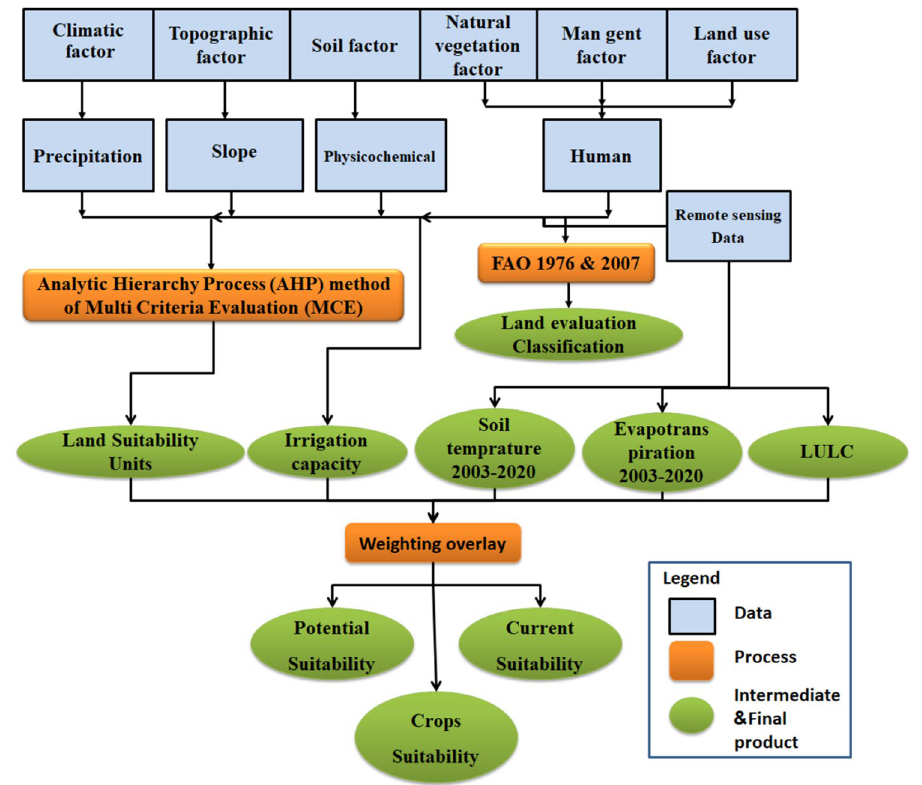
Figure 3. Data processing flow chart for generating land evaluation